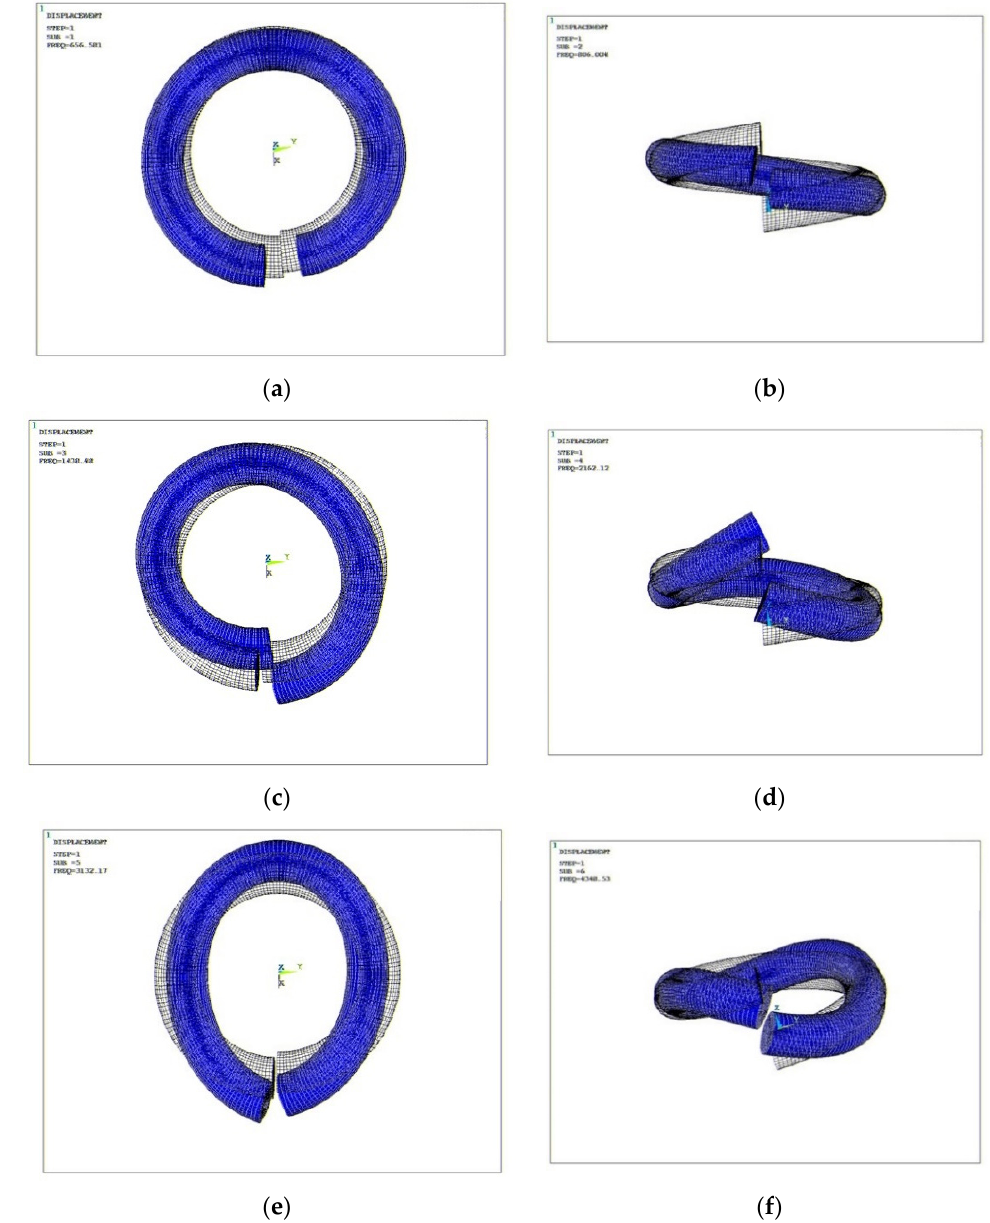
Figure 8. Modes of vibration of a spring: ( a ) Bending 1; ( b ) Torsional 1; ( c ) Bending 2; ( d ) Torsional 2; ( e ) Bending 3; ( f ) Torsional 3.